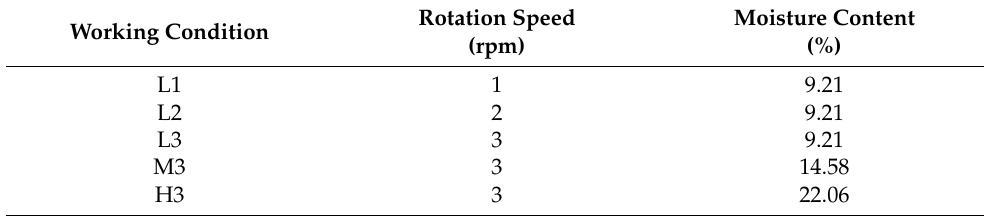
Table 2. Rotary dryer operating conditions.